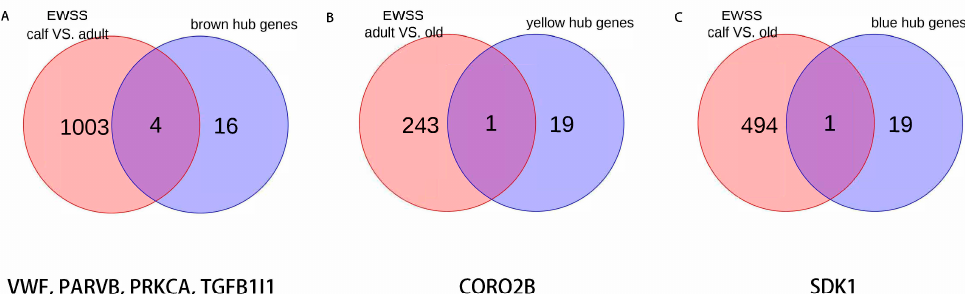
Figure 7 . ( A ) Venn diagram of EWSS calf vs. adult and brown module hub genes. ( B ) Venn diagram of EWSS adult vs. old and yellow module hub genes. ( C ) Venn diagram of EWSS calf vs. old and blue module hub genes.